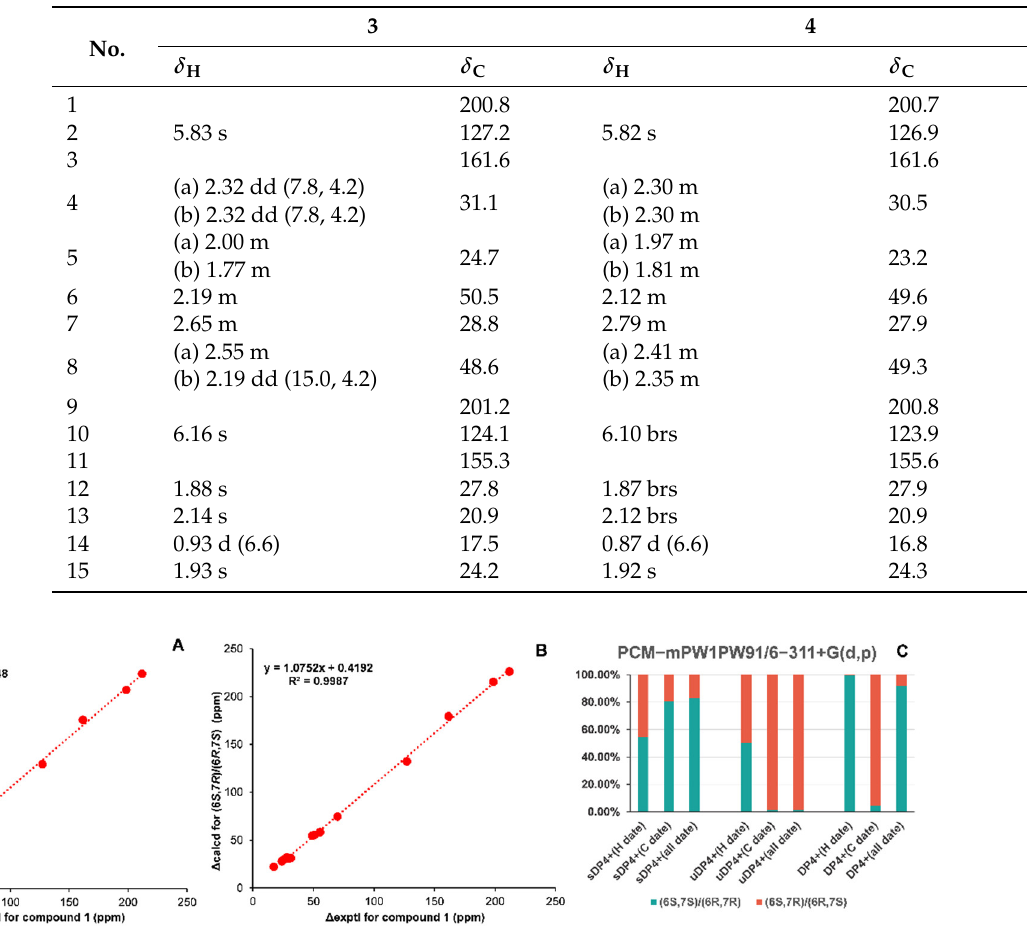
Figure 3. Comparison of the experimental and calculated NMR chemical shifts of compound 1 . ( A ) Regression analysis of experimental 13 C NMR chemical shifts of compound 1 vs. calculated 13 C NMR chemical shifts of (6 S ,7 S )/(6 R ,7 R )- 1 . ( B ) Regression analysis of experimental 13 C NMR chemical shifts of compound 1 vs. calculated 13 C NMR chemical shifts of (6 S ,7 R )/(6 R ,7 S )- 1 . ( C ) DP4+ probability for (6 S ,7 S )/(6 R ,7 R )- 1 and (6 S ,7 R )/(6 R ,7 S )- 1 at the PCM-mPW1PW91/6-311+G(d,p)